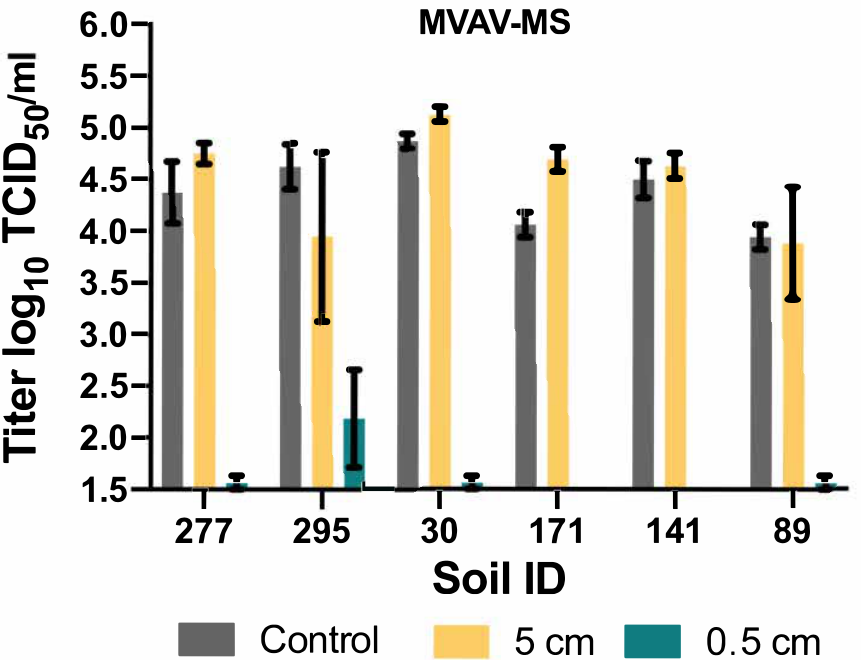
Figure 3. Penetrability of 0.1% peracetic acid on MVA-germ carriers at 0.5- and 5-centimeter depth in ( top panel ) in topsoil (TS), ( lower panel ) in mineral soil (MS); limit of detection 10 1.5 log 10 TCID 50